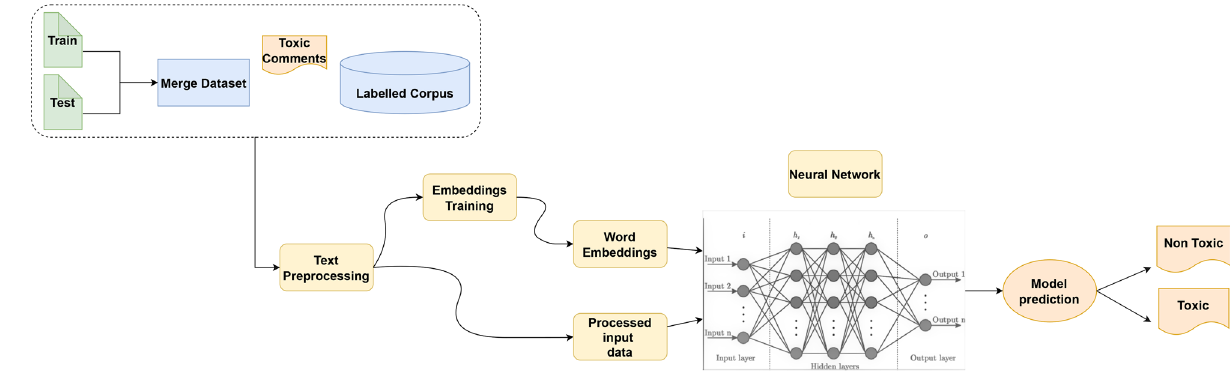
Figure 1. Proposed solution for toxic comments detection and